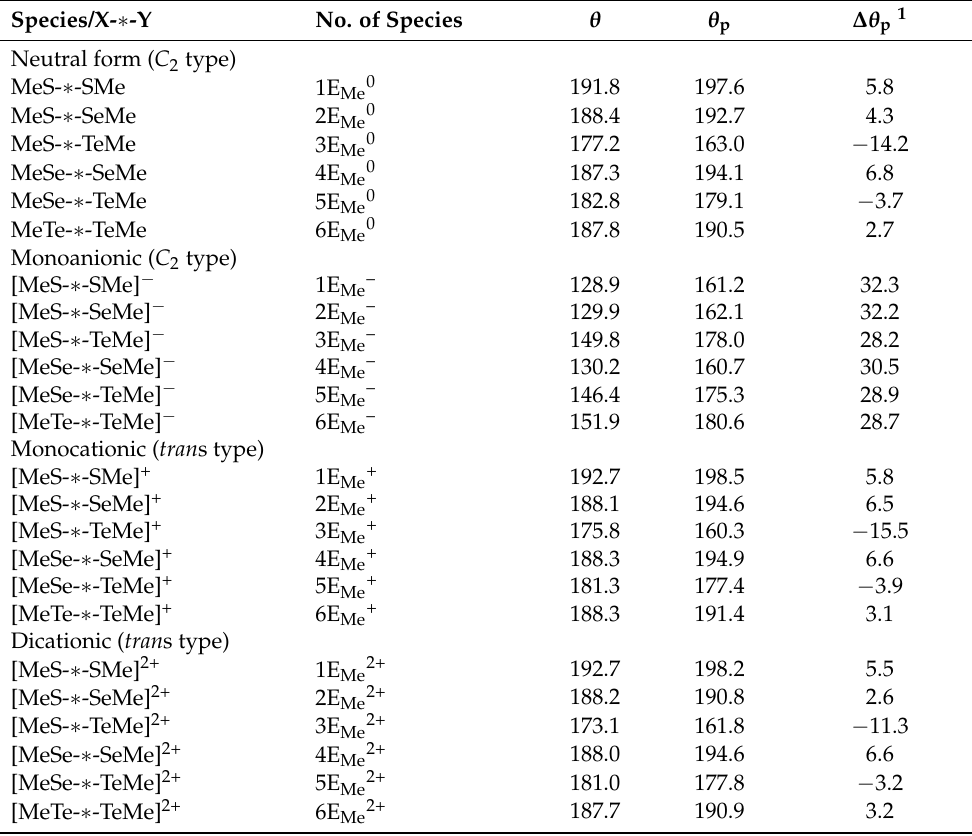
Table 2. The θ , θ p and ∆ θ p values for the neutral, monoanionic, monocationic and dicationic forms